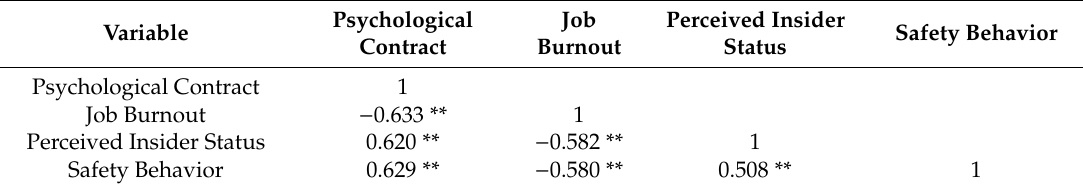
Table 5. The results of correlation